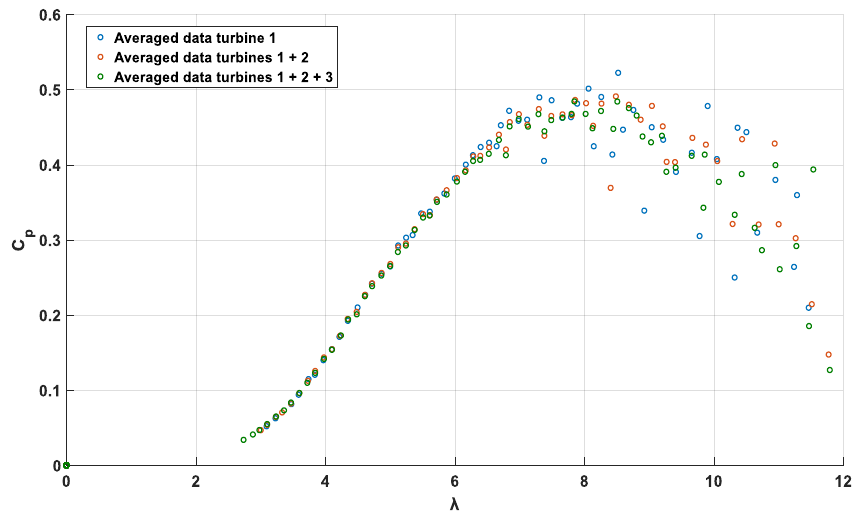
Figure 6. 𝜆 - 𝐶 𝑝 coordinates obtained after the filtering and weighting process. Figure 6. λ - C p coordinates obtained after the filtering and weighting